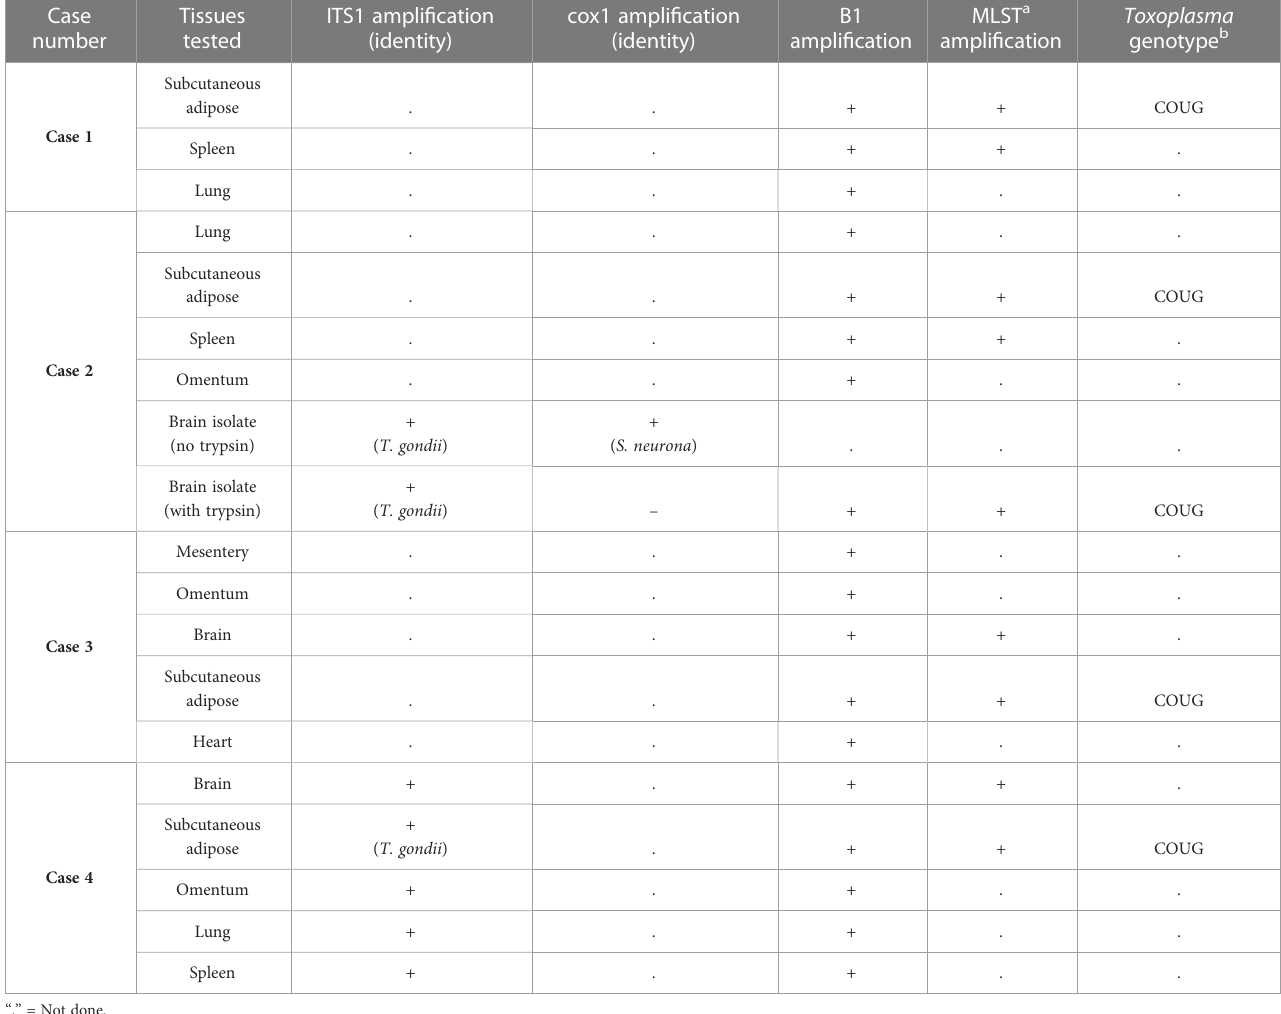
TABLE 3 Findings from molecular characterization using PCR and MLST for southern sea otters ( Enhydra lutris nereis ) with fatal Toxoplasma gondii - associated steatitis and toxoplasmosis. Case